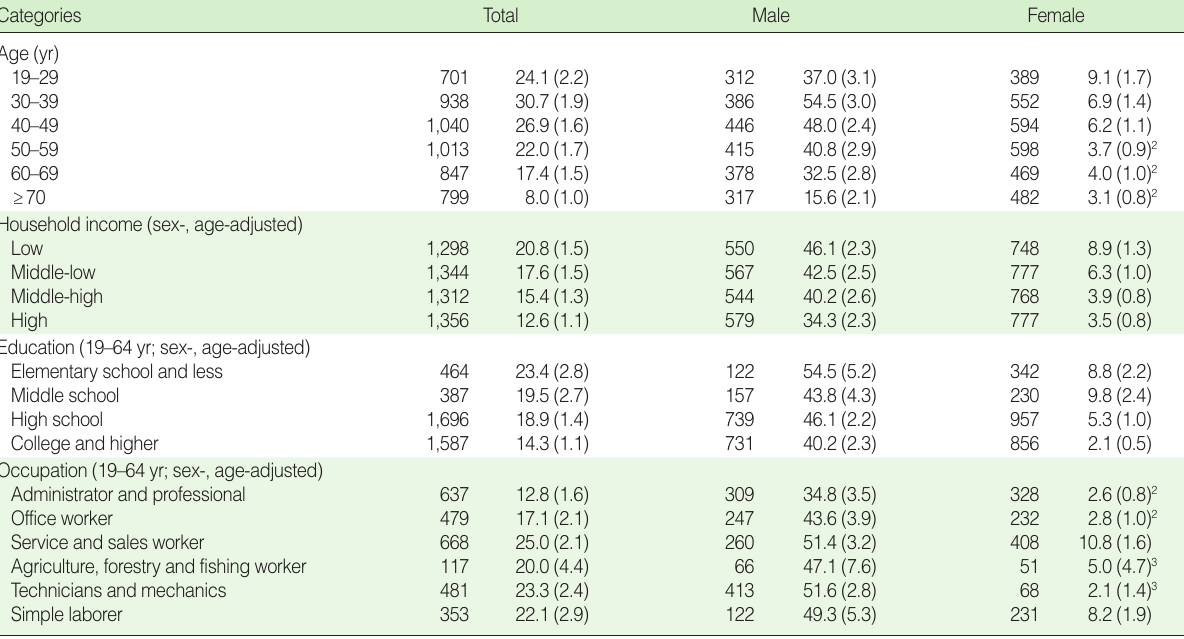
Values are presented as number or % (standard error). 1 Percentage of adults who had smoked at least 5packs of cigarettes (100 cigarettes) during their lifetime and who are currently smokers (aged 19 years and older). 2 Coefficient of variability is 25–50%.